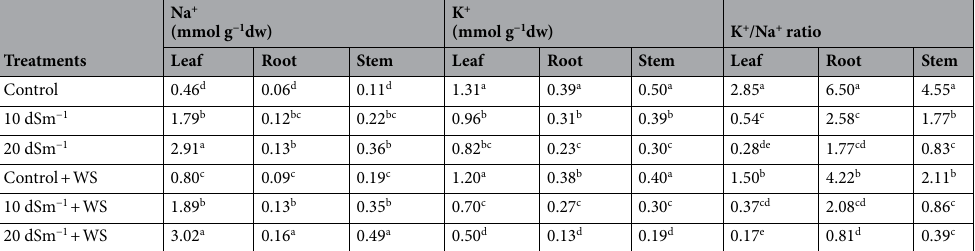
Table 3. Concentrations of Na + , K + , and K + /Na + ratio in Psidium guajava exposed to the salt (NaCl) and drought stress (low water supply). Data refer to mean values (n = 3). The same letters along with columns are not significantly different according to the Tukey HSD post hoc test after ANOVA ( p ≤ 0.05). D = Water stress; dw = dry weight; dSm −1 = desiSiemens per